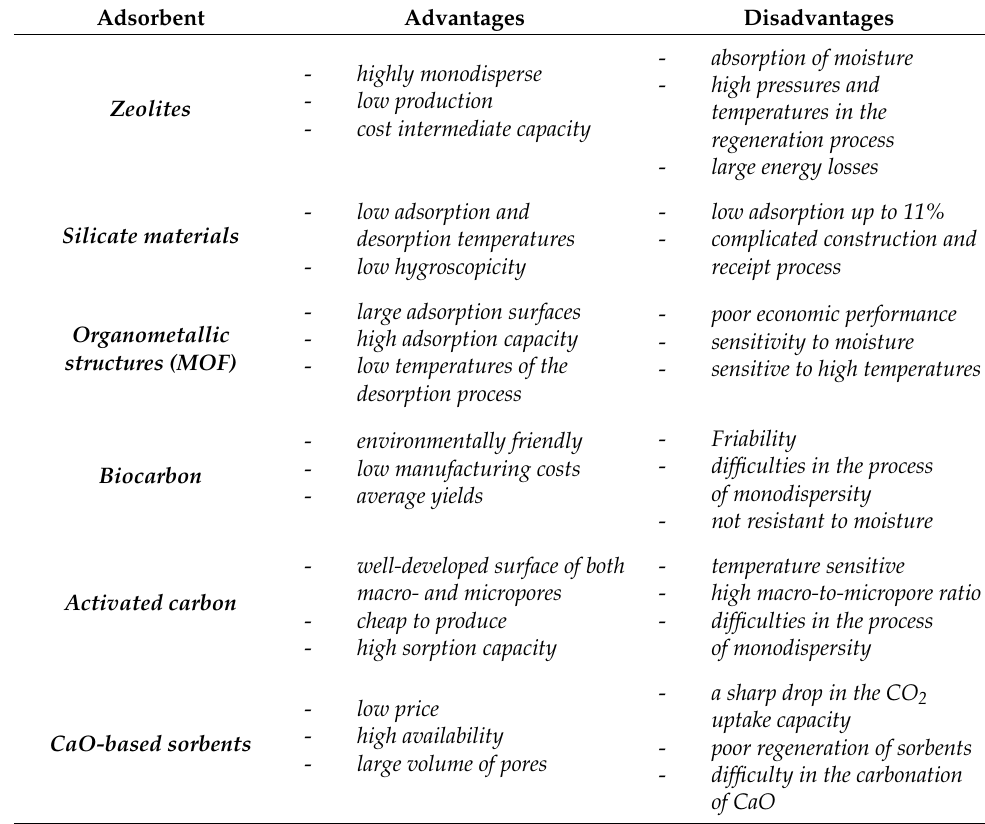
Table 1. Advantages and disadvantages of the adsorbents used in CO 2